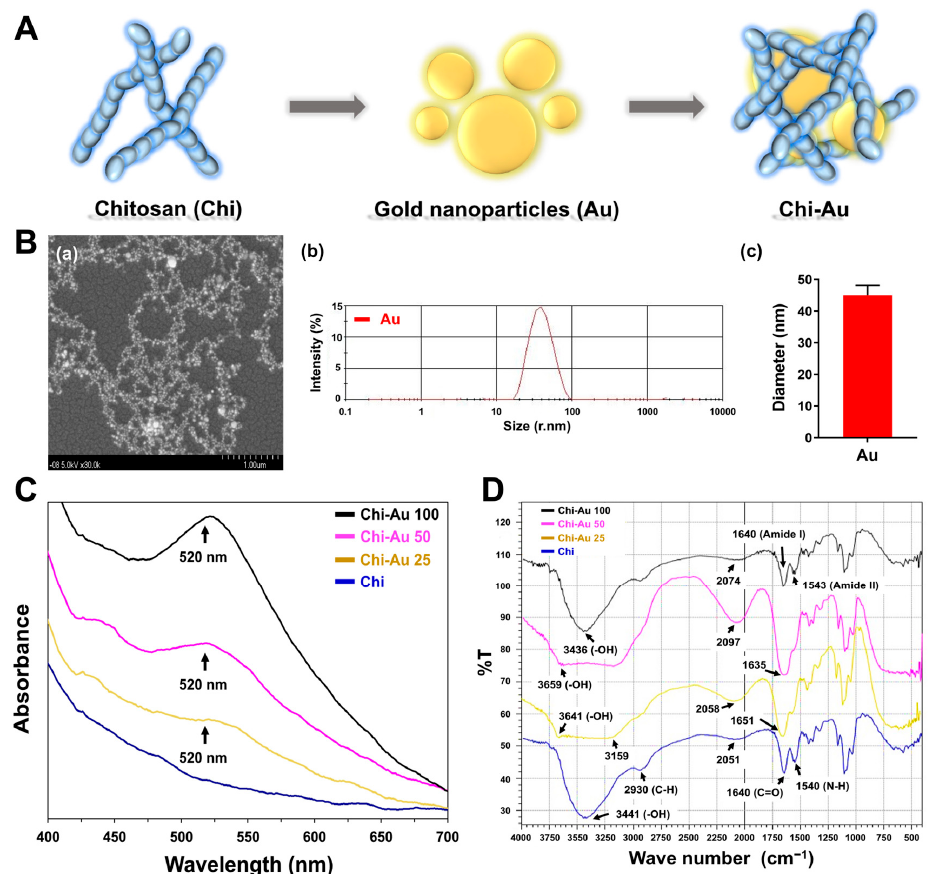
Figure 1. Characterization of the as-prepared materials. ( A ) Brief concept of preparing Chi–Au nanocomposites. ( B ) The (a) SEM image and (b) DLS assay for identification of the Au nanoparticles. Scale bar was set as 1 μ m. (c) The diameter of the Au nanoparticles was 45 ± 3.2 nm. ( C ) UV-Vis spectrum for Chi fabricated with various concentrations of Au nanoparticles (25, 50, and 100 ppm). The peak at 520 nm indicated as Au. ( D ) The FTIR spectrum for Chi–Au (25, 50, and 100 ppm) nanocomposites ranged from 400 to 4000 cm − 1 wavenumber. The results are represented as three independent experiments.